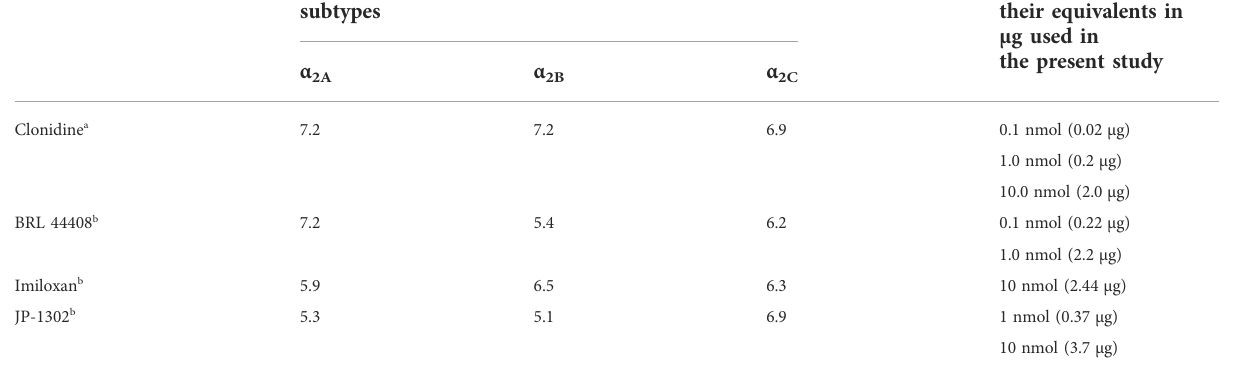
TABLE 1 Binding af fi nity constants for the α 2A -, α 2B -, and α 2A -adrenoceptors of clonidine and the antagonists used in the present study. The nanomoles (and their equivalents in μ g) spinally administered in the current experiments are also shown.